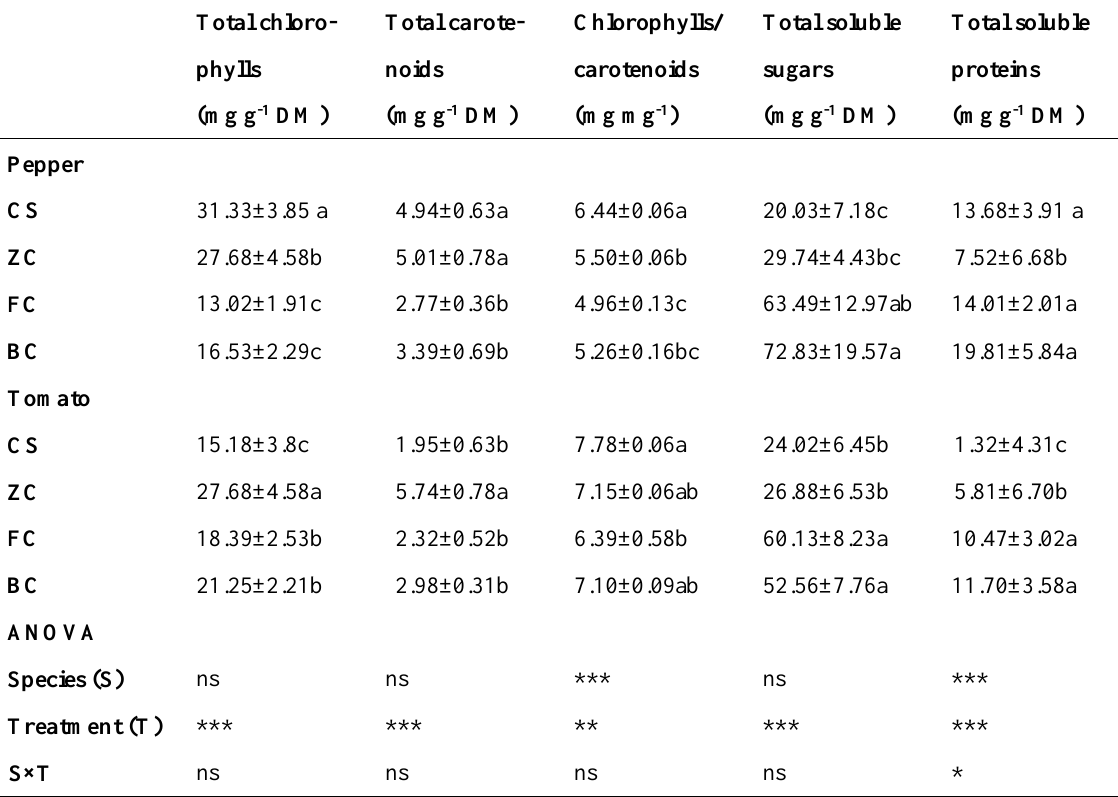
Table 4 Leaf pigments and primary metabolites of pepper and tomato seedlings grown in perlite